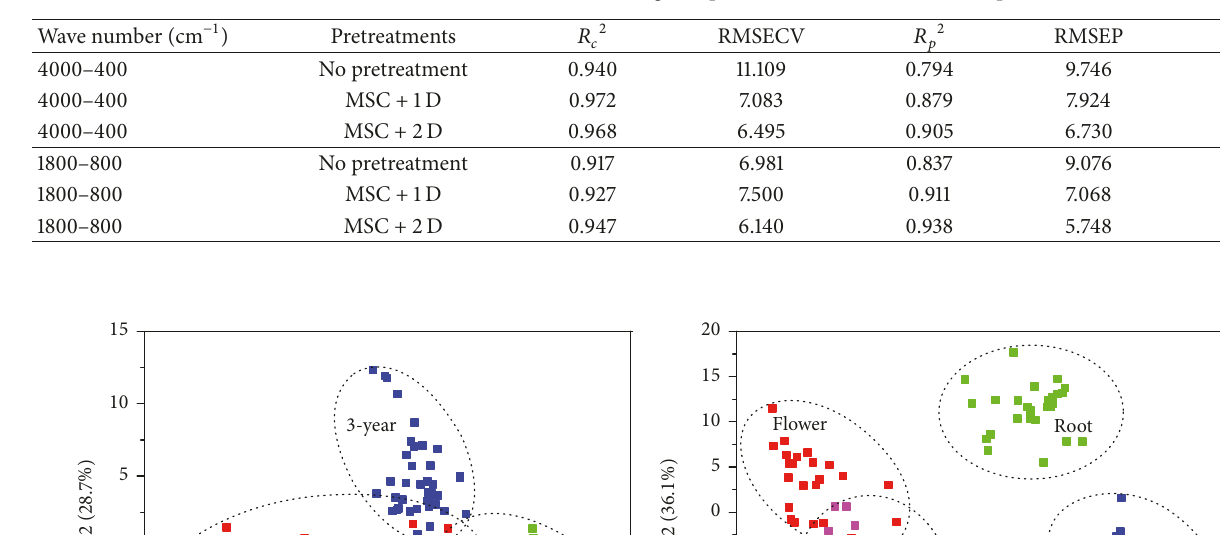
Table 3: The results for determination of gentiopicroside based on PLSR technique.